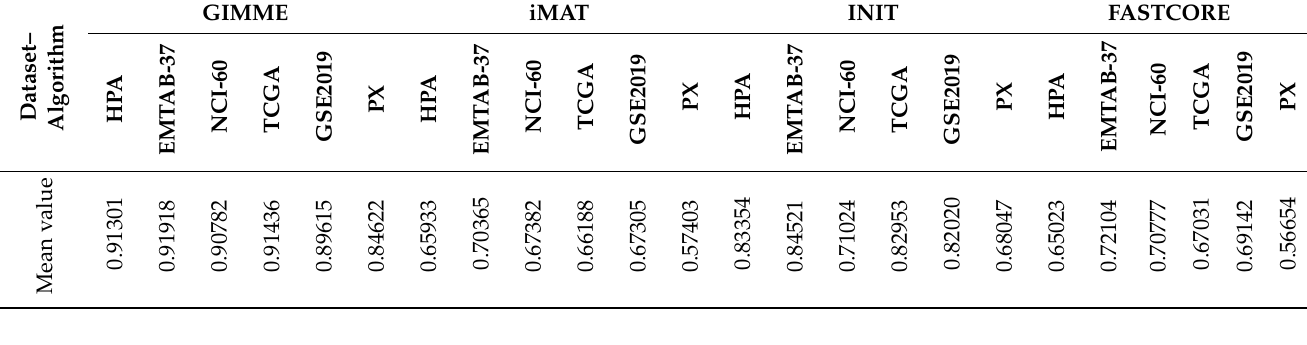
Table 5. The mean value of Jaccard similarity index among the number of active reactions in the metabolic subsystems.